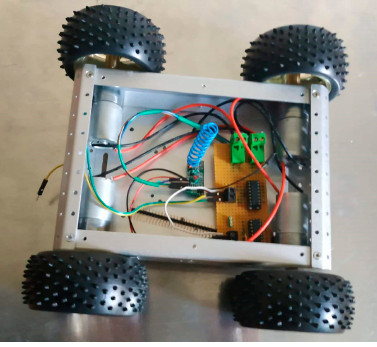
Figure 3. Chassis top view with motors and receiver.